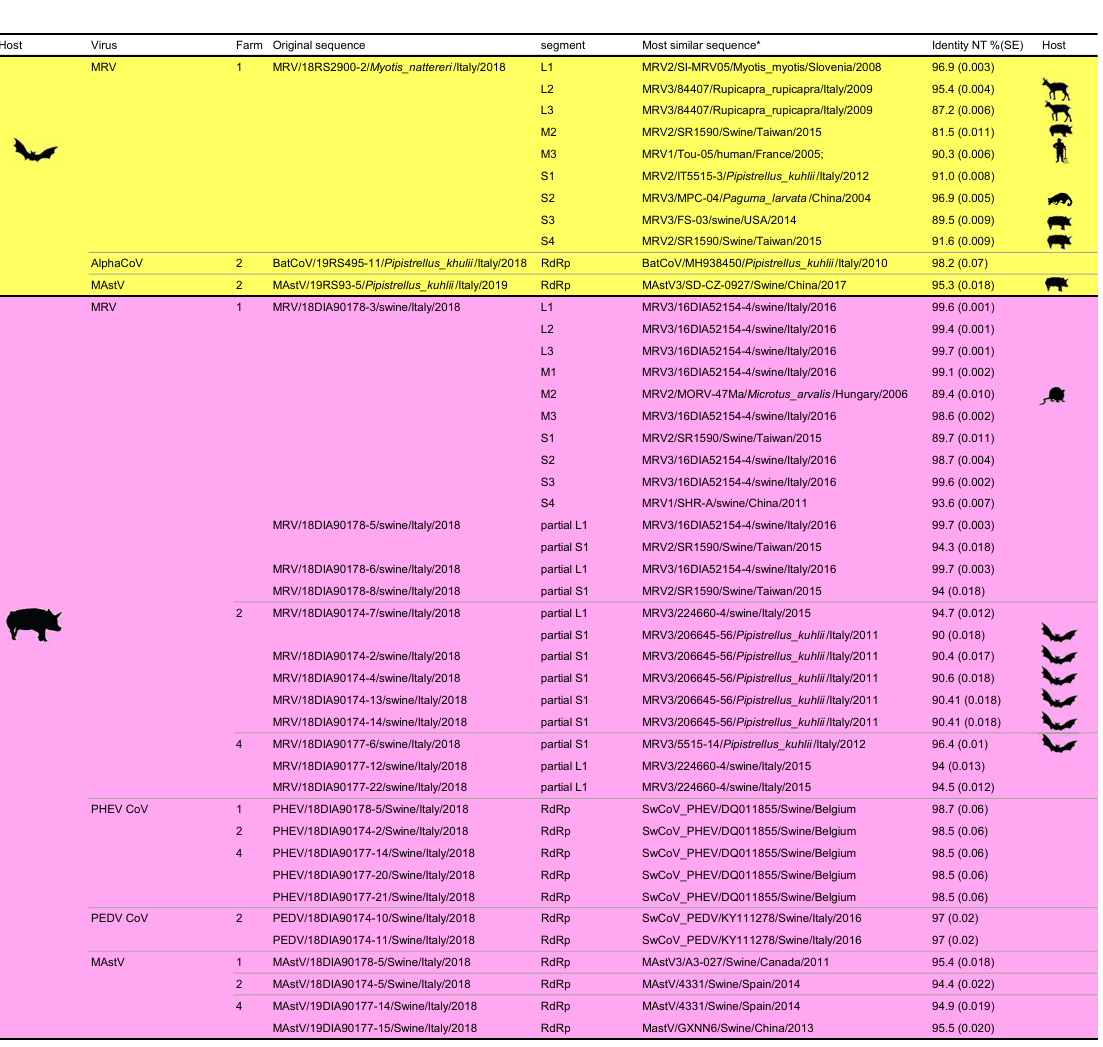
Figure 1. Sequences with the highest identity for all original strains found within the study, including the relative host